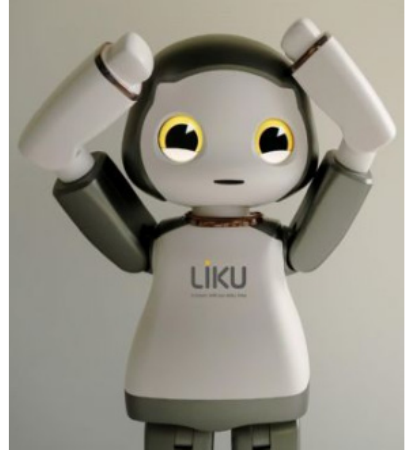
Figure 1. Experimental